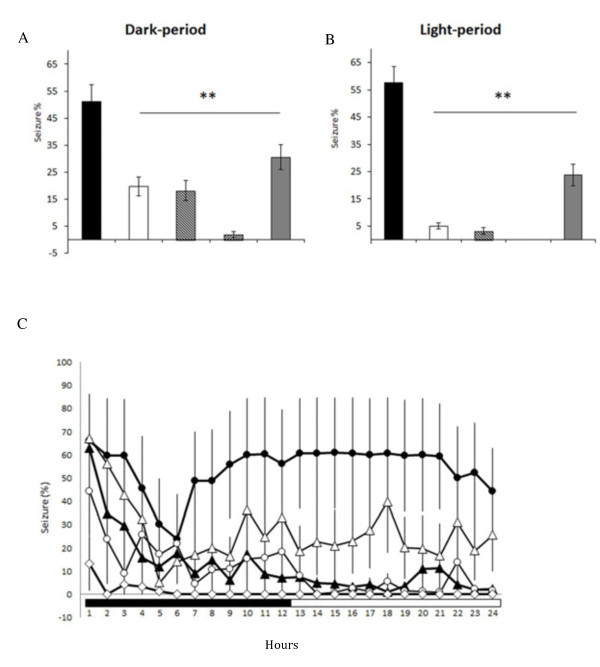
The summary for the effects of naloxone, naloxonazine, naltrindole and nor-binaltorphimine on the 100 Hz EA-induced exacerbation of epileptic activities. Panel A depicts the results obtained from the dark period and panel B demonstrates the data acquired from the light period. The bars from the left to the right in both panels A and B represent the results obtained from the PFS + EA + pilocarpine group, naloxone + EA + pilocarpine group, naloxonazine + EA + pilocarpine group, naltrindole + EA + pilocarpine group and nor-binaltorphimine + EA + pilocarpine group. In panel C, the black circles represent the values obtained from the PFS + EA + pilocarpine group, the black triangles depict the results of the naloxone + EA + pilocarpine group, the white circles demonstrate the values obtained from the naloxonazine + EA + pilocarpine group, the white diamonds elucidate the results of the naltrindole + EA + pilocarpine group, and the white triangles indicate the data acquired from the nor-binaltorphimine + EA + pilocarpine group. **: p < 0.01 vs. the PFS + EA + pilocarpine group.